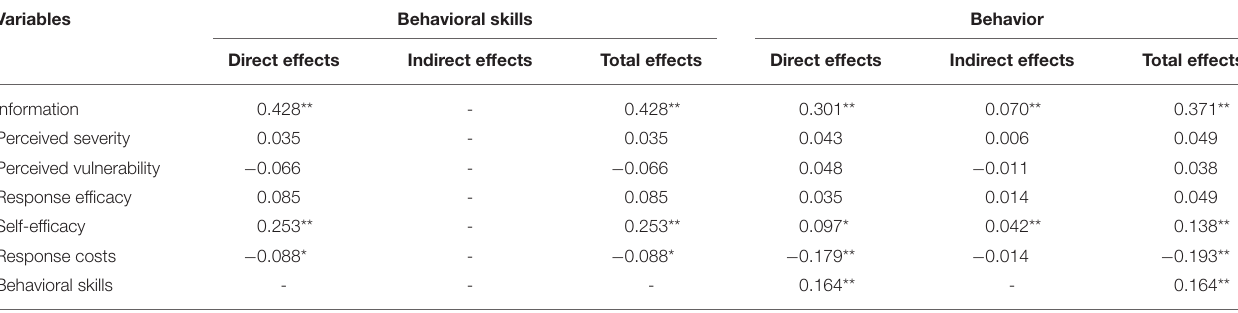
TABLE 7 | The direct, indirect, and total effects among the latent variables in the structural model.